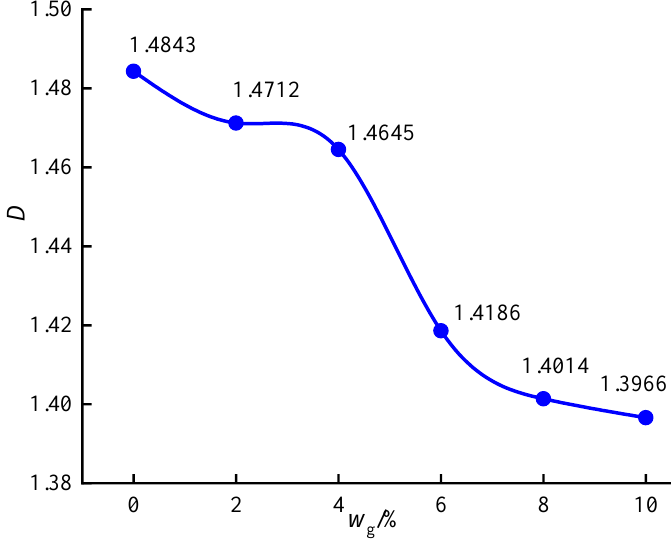
Figure 19. Fractal dimension of solidified silt under different dosages of PZ – 1.